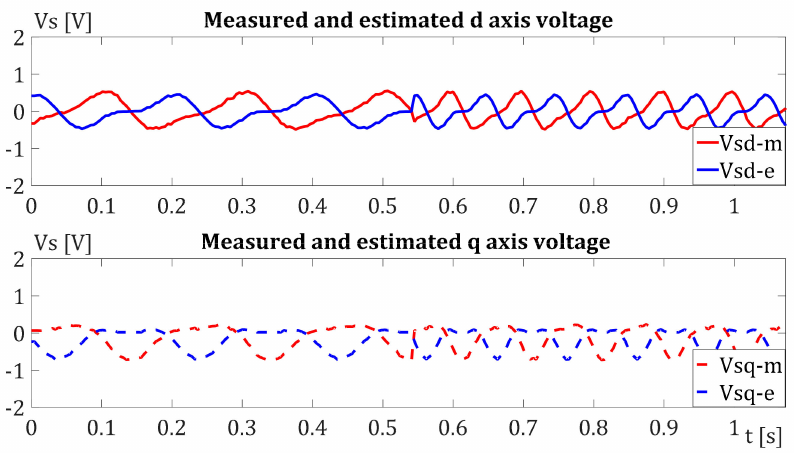
Figure 8. Experimental results for measured and estimated voltage (parameters of voltage estimator detuned).